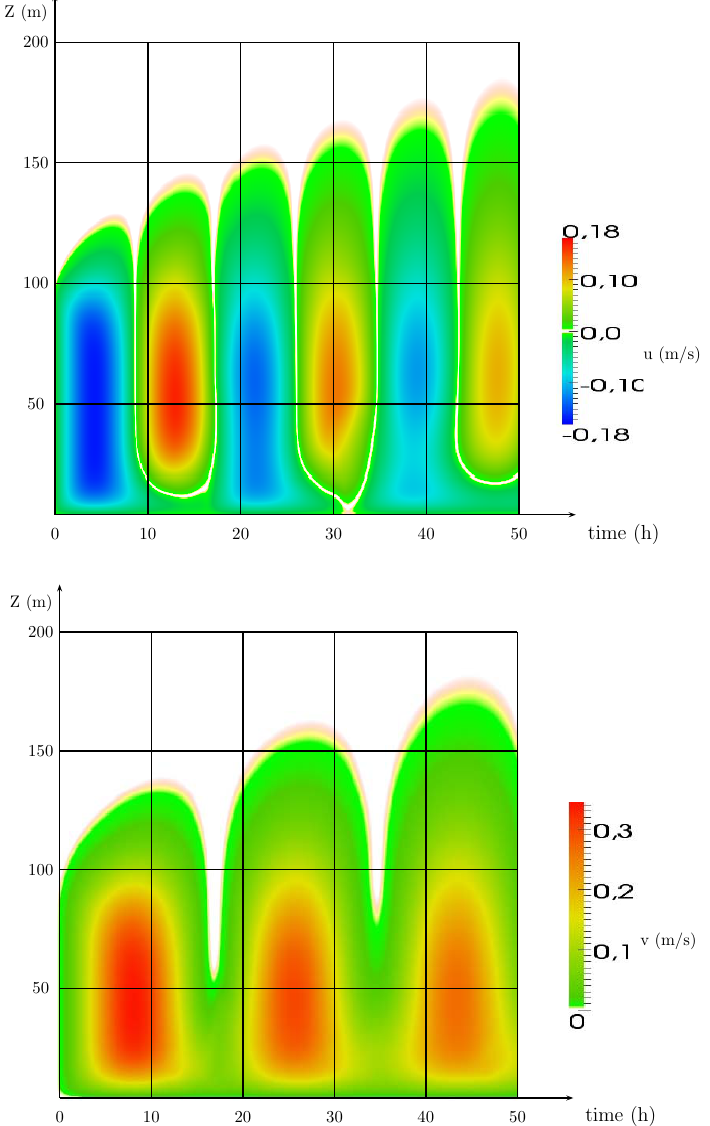
Fig. 6. Inertial oscillations dominate the up-slope velocity h u i (left) and cross-slope velocity h v i (right) in ms − 1 . The interface is at z =